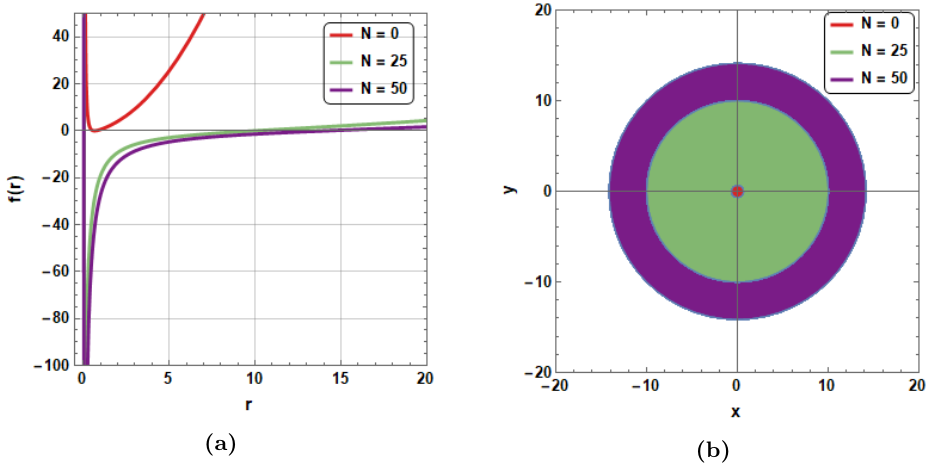
Figure 15. (a): evolution of f ( r ) function during an absorption of 10 5 over 50 periods . (b): evolution of black hole projection on xy plan during an absorption of 10 5 over 50 periods. The initial conditions are Q = 1 , l = 1 , M = 1 . 23 , r h = 0 . 65 and D = 4